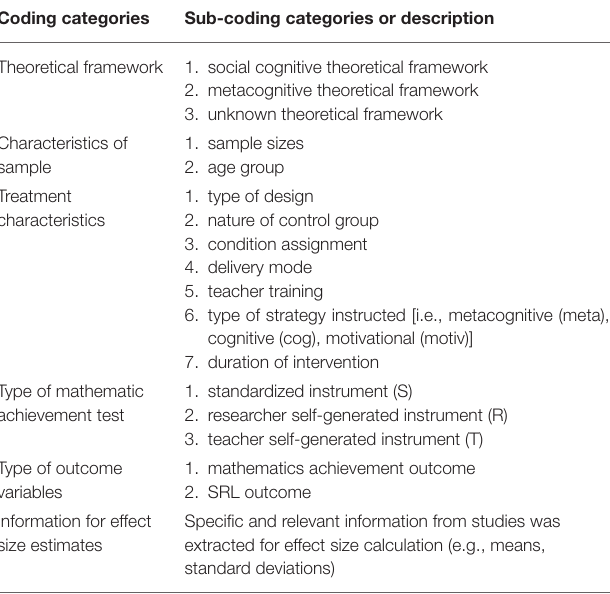
TABLE 3 | Coding scheme for identified